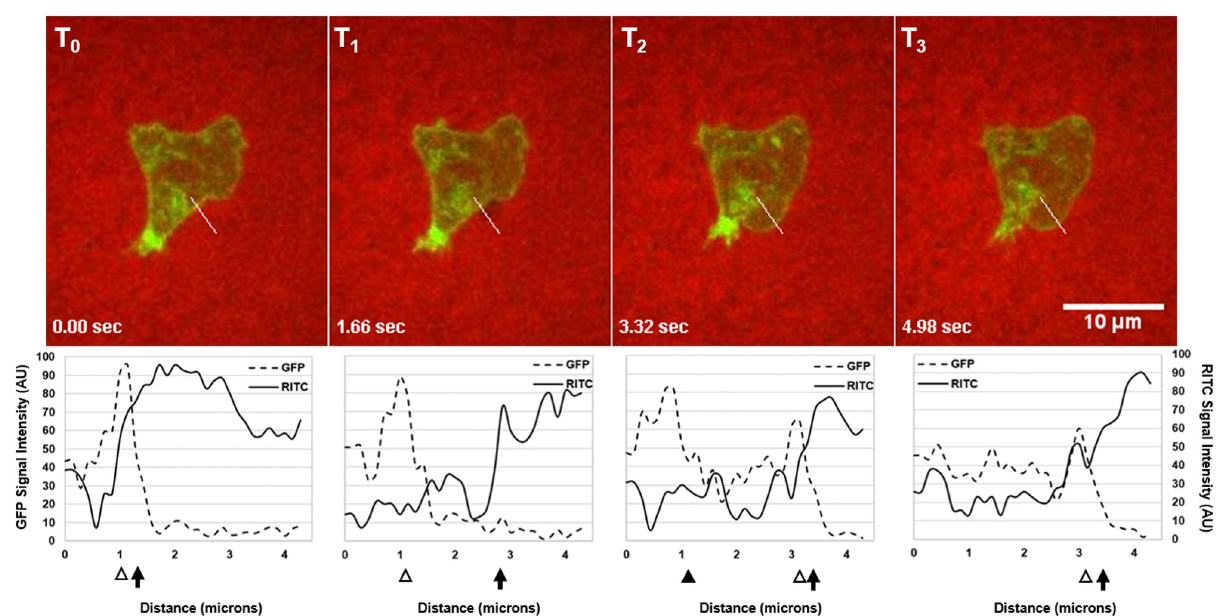
Fig 4. ImageJ intensity plots confirmed cortex-to-membrane positions throughout bleb formation of a putative bleb. Merges of GFP and RITC time points representative of steps in bleb formation ( T 0 - T 3 ) with their respective intensity plots (dashed and solid lines) from the same cell in Fig 2 confirmed bleb formation quantitatively in real-time along the line drawn (white). Cortex positions (white arrowhead), the actin scar characteristic (black arrowhead), and membrane (black arrow) positions are indicated.